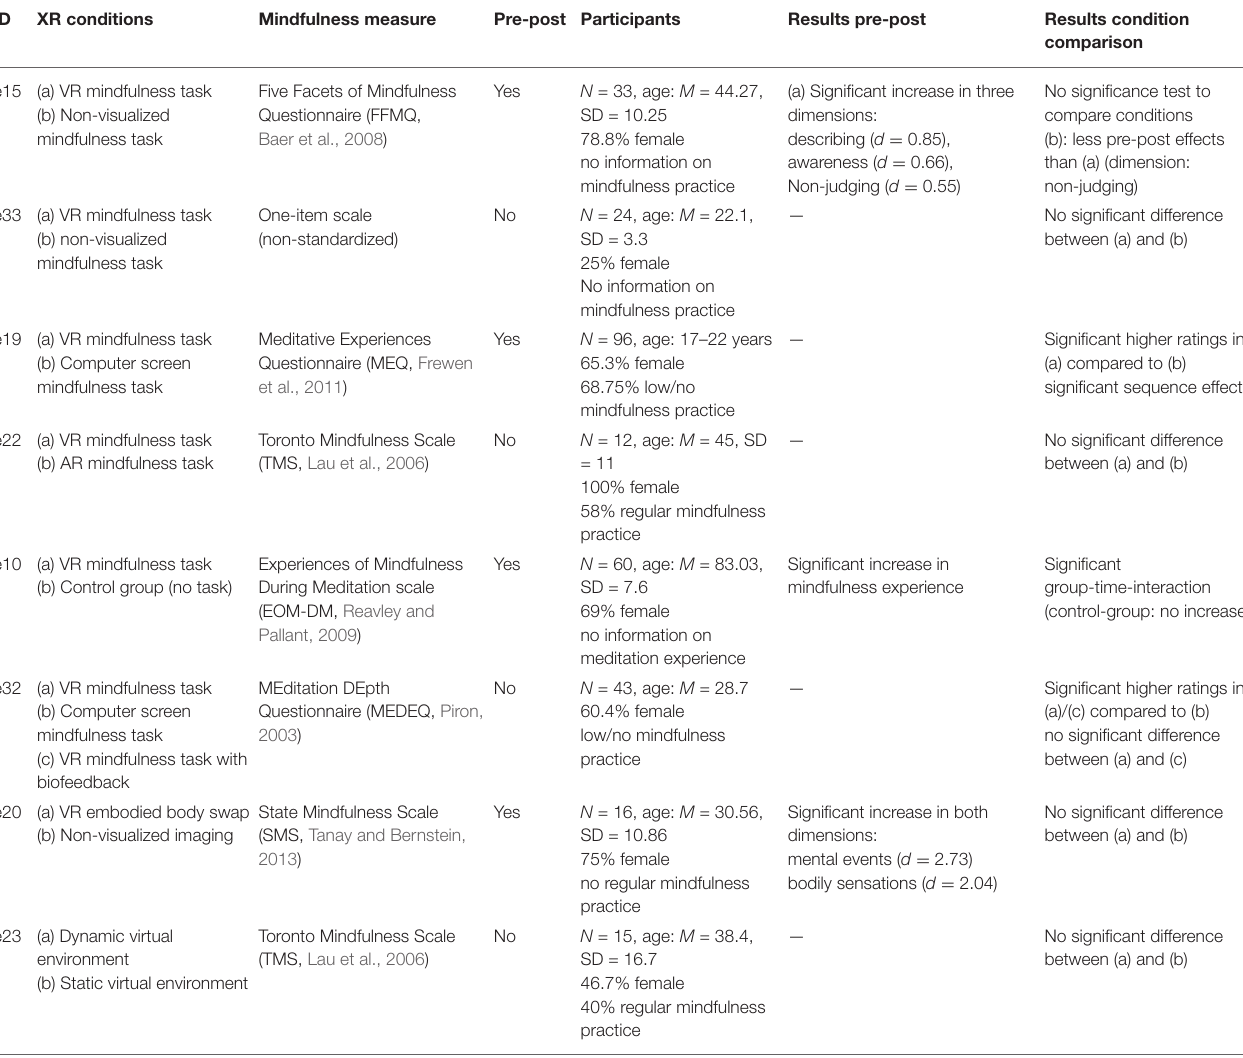
TABLE 2 | Overview of the papers included in the effect synthesis. ID XR conditions Pre-post Participants Results pre-post Results condition